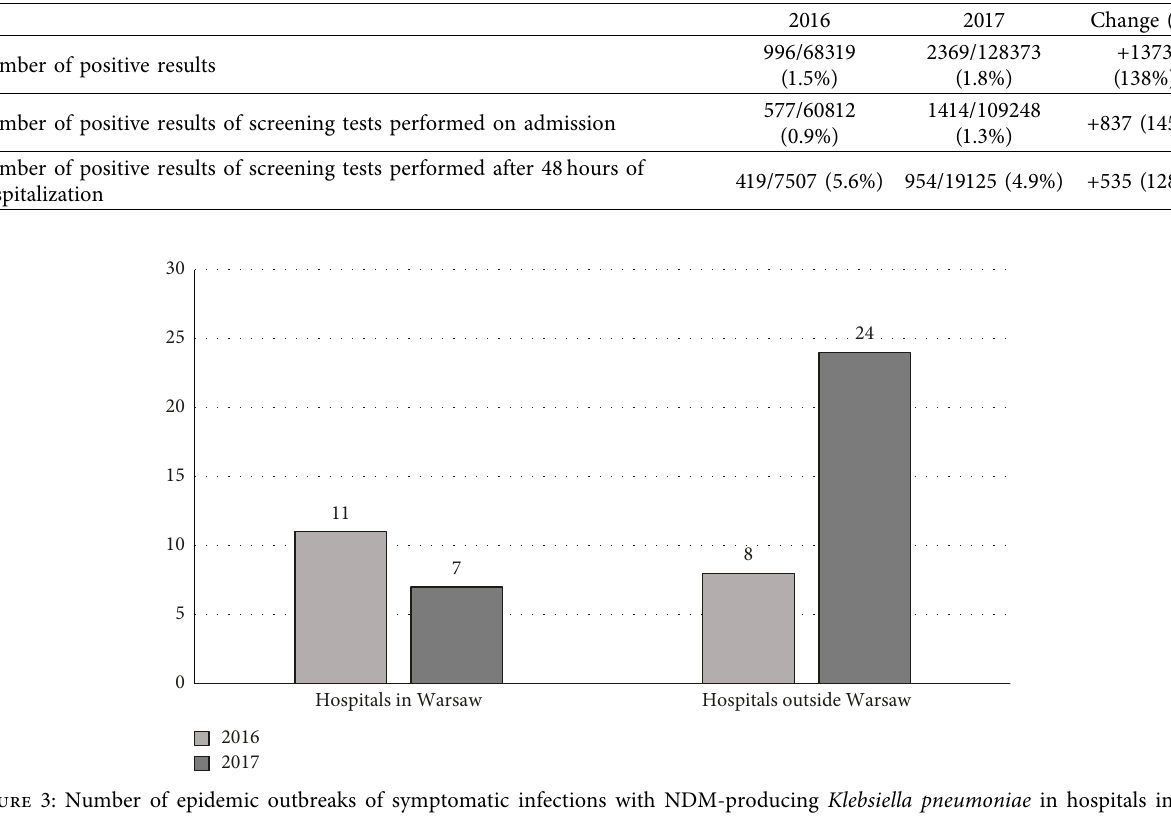
Table 3: Number of positive results of microbiological screening tests performed in hospitals in the Mazovian Voivodeship in 2016–2017.